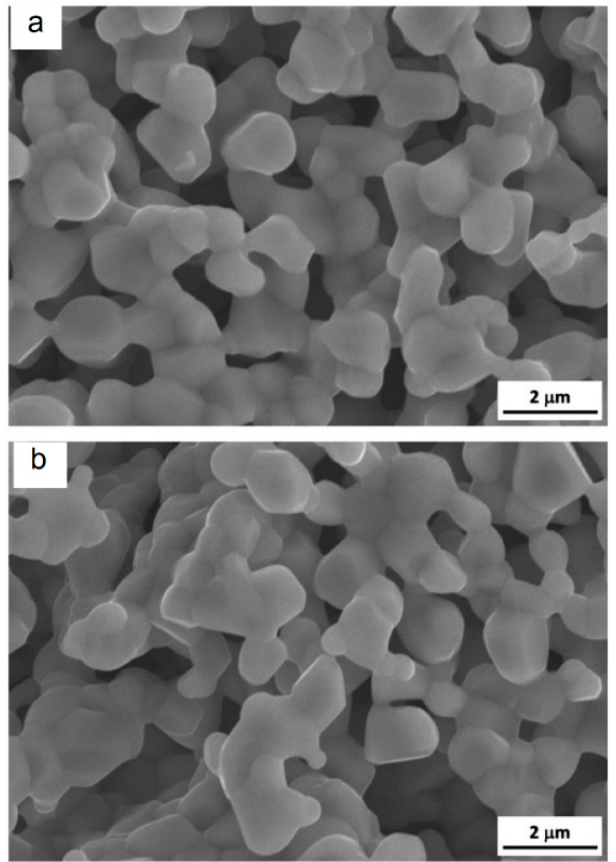
Figure 19. Surface of ZrB 2 porous compacts synthesized at 1600 °C, holding time 10 min ( a ), 20 min ( b ). Reprinted from Yuan et al. [66], Copyright (2012), with permission from Elsevier.